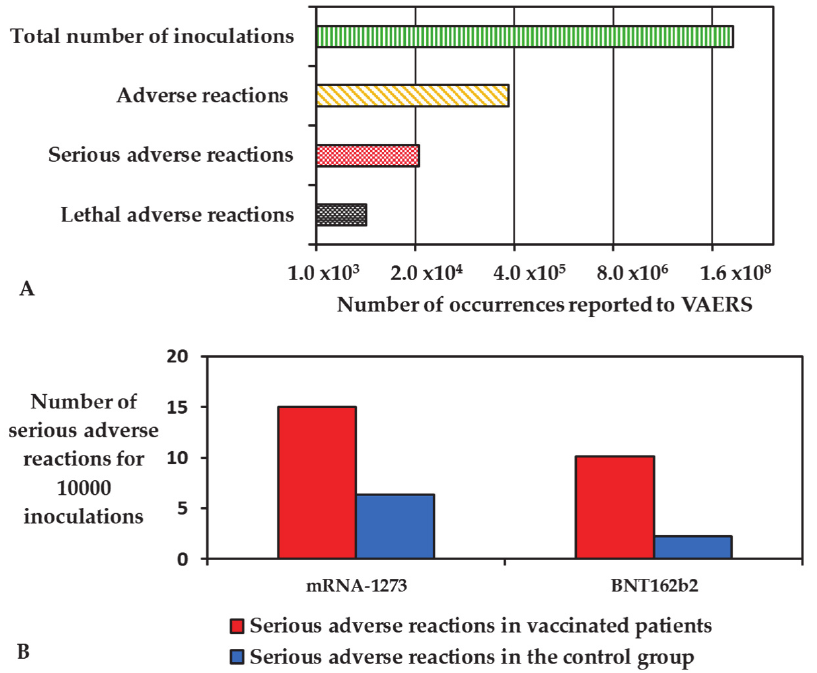
Figure 1. ( A ) Adverse reactions reported to the VAERS database in comparison with the total inoculations in US after 6 months of vaccination campaign; ( B ) comparison between the serious adverse reactions reported during the clinical trials of the mRNA vaccines and their placebo control groups.